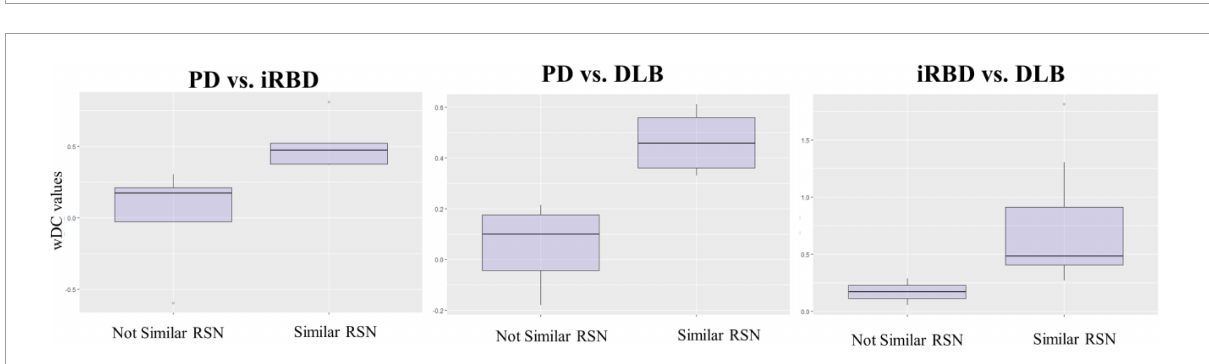
FIGURE4 wDC values in similar and not similar RSNs. The figure represents the mean values of wDC in RSN classified as similar and not similar in iRBD vs. PD, PD vs. DLB, and RBD vs. DLB comparison (from right to left).